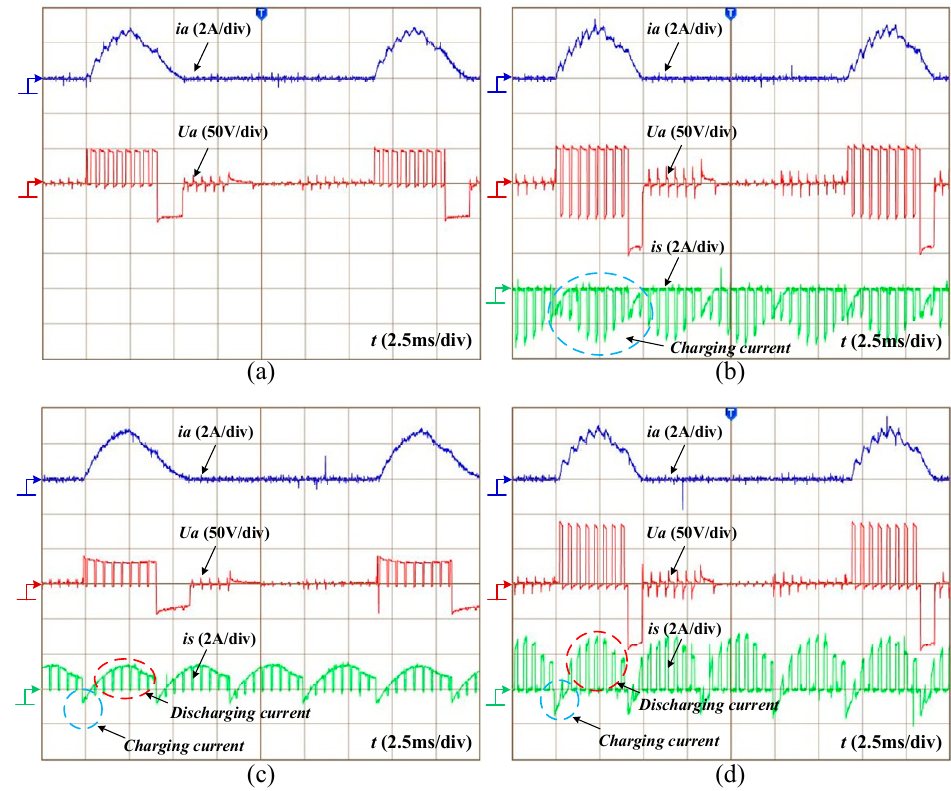
Figure 18. Experimental waveforms of 600rpm performance with SRM driven by ( a ) the conventional converter, ( b ) the PV panel, ( c ) the battery bank. and ( d ) the dual-source.